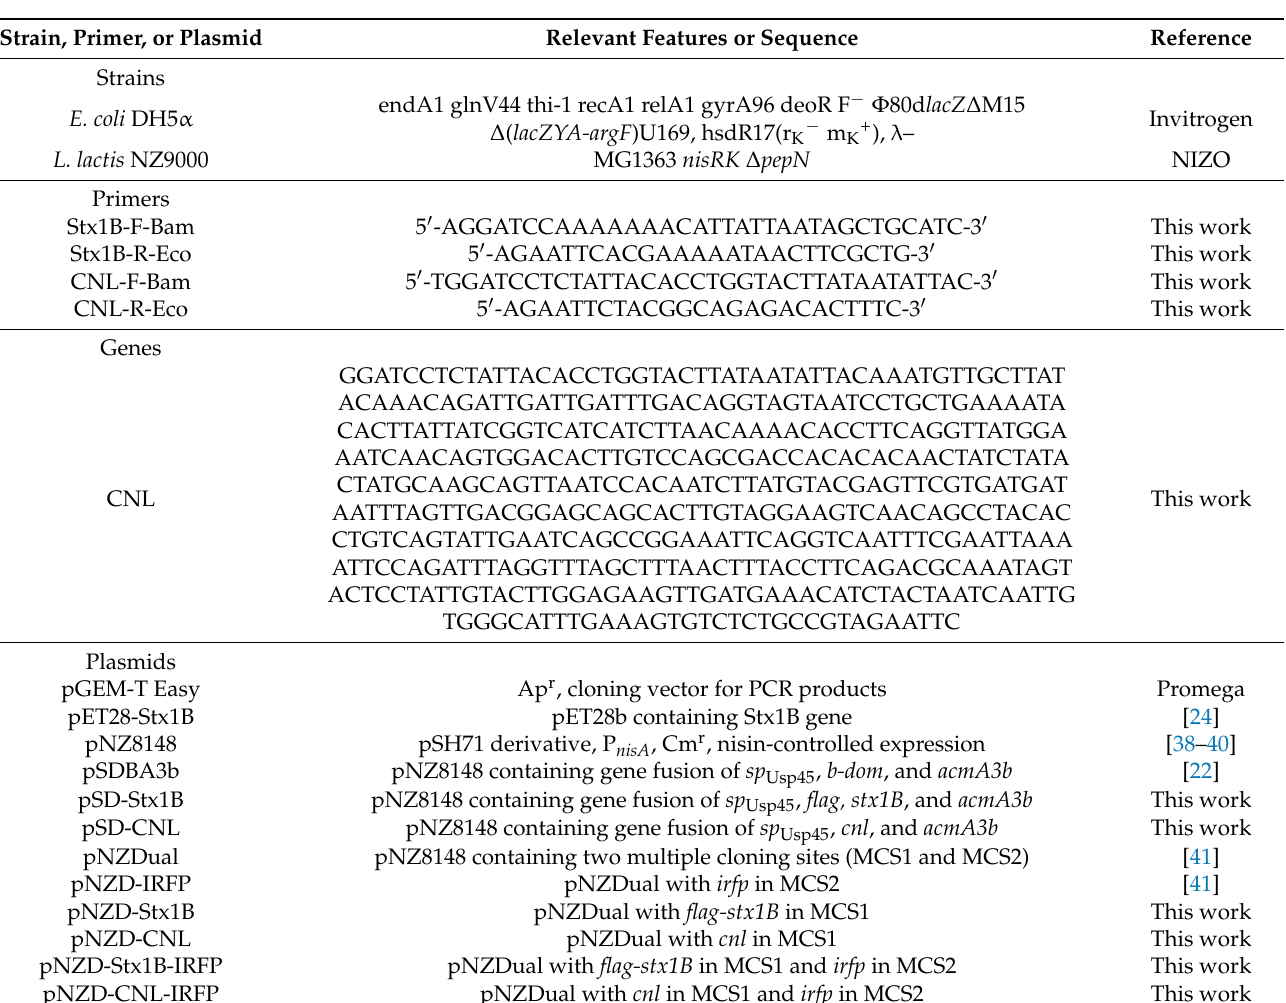
Table 1. Strains, primers, and plasmids used in this